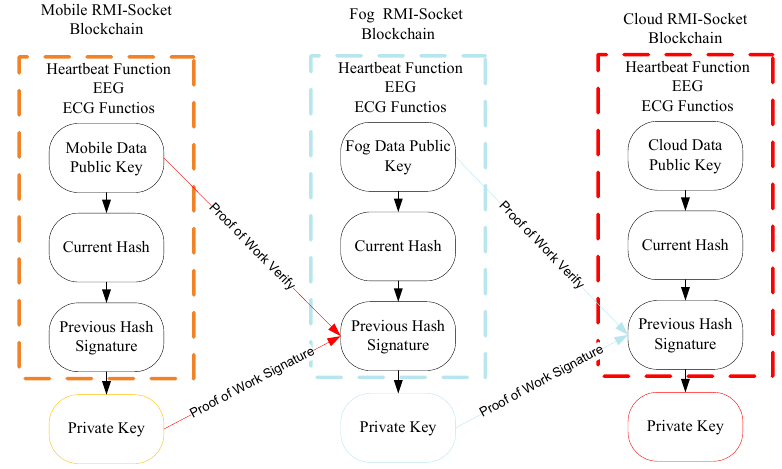
Figure 3. Blockchain